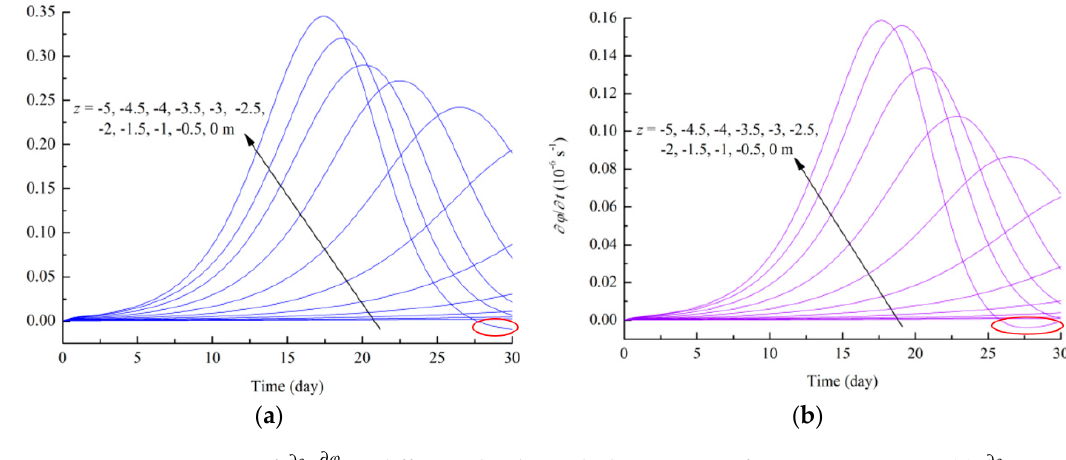
Figure 9. Variations of ∂ c